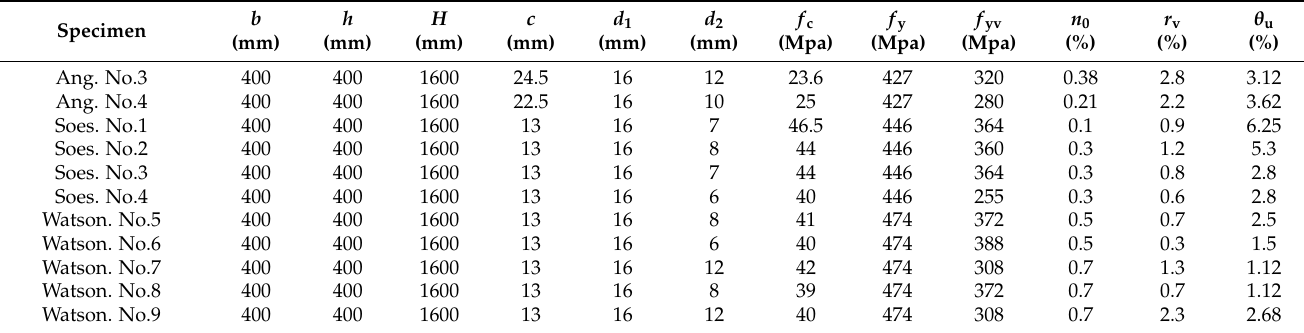
Table A1. Parameters of test specimen used in this